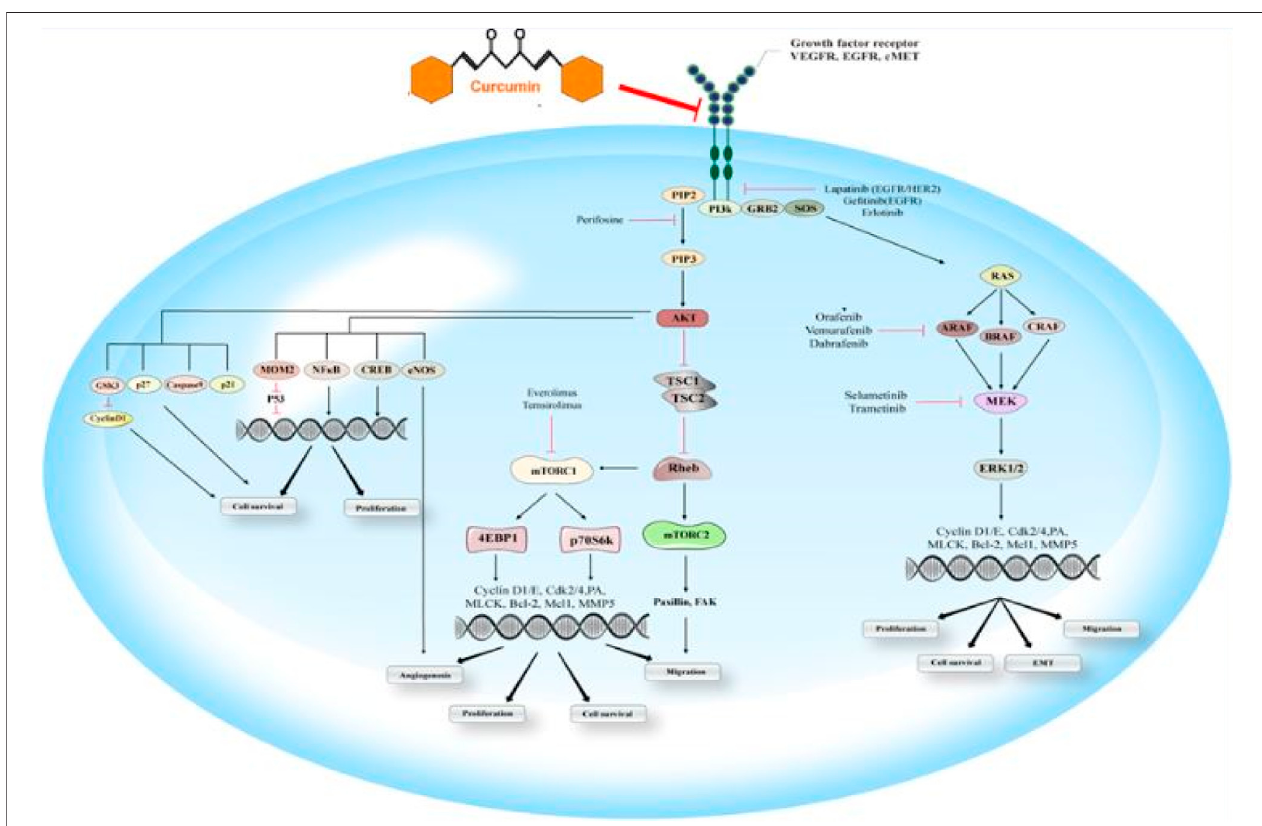
FIGURE 4 | EGFR signaling pathway: This schematic indicates the essential components of the RAS/RAF/MEK/ERK and PI3K/Akt/mTOR signaling pathways andtheiref fi cacyonthecascadeofmetastasis.EGFR,anactivatedreceptortyrosinekinase,triggersbothcascadesthatresultinthestimulationofAkt,mTOR-1/-2,and ERK as the downstream effectors. Some drug agents target these signaling pathways, including panitumumab, vemurafenib, dabrafenib, cetuximab, trastuzumab, and ge fi tinib, sorafenib, selumetinib, lapatinib, temsirolimus, erlotinib, perifosine, trametinib, everolimus. Curumin is able to inhibit EGFR signaling.